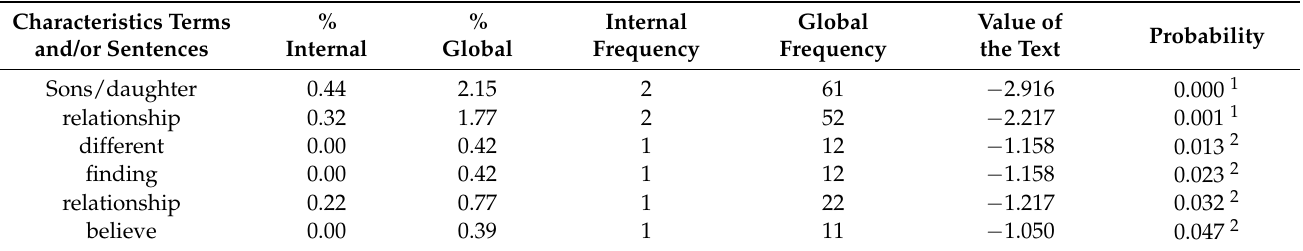
Table 4. The words less used by the parents in answer to the question: “What is, in your opinion, the cause of school drop-out”.